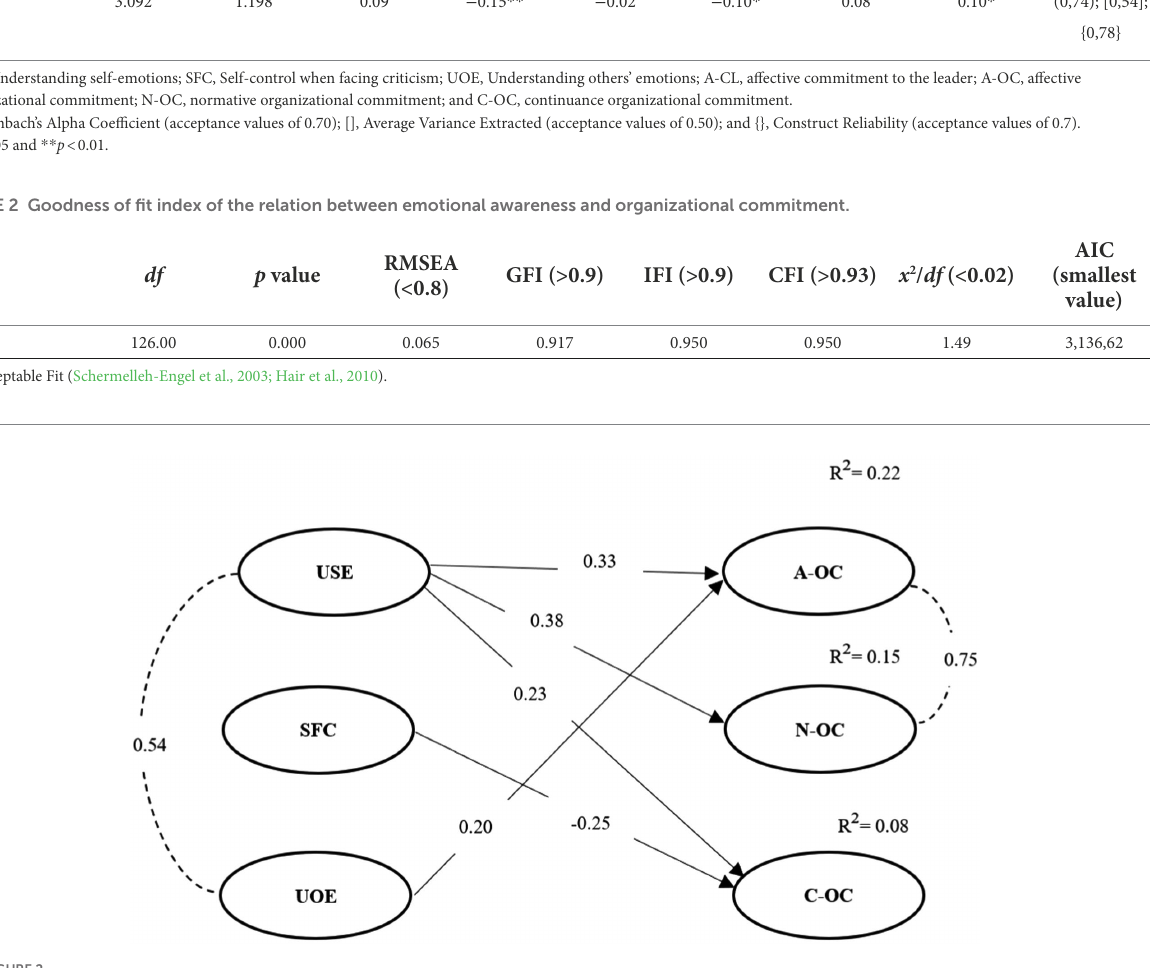
awareness regarding the three dimensions of organizational commitment (affective, normative, and continuance) was identified. We found that Understanding self-emotions and Understanding others’ emotions explain 22% of affective organizational commitment. It is also noteworthy that